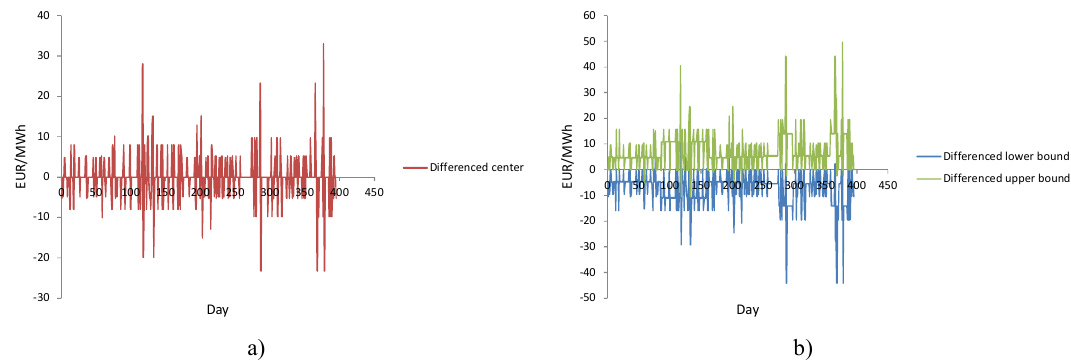
Figure 7. Stationary quality of: ( a ) differenced fuzzy time series and ( b ) differenced interval time series.